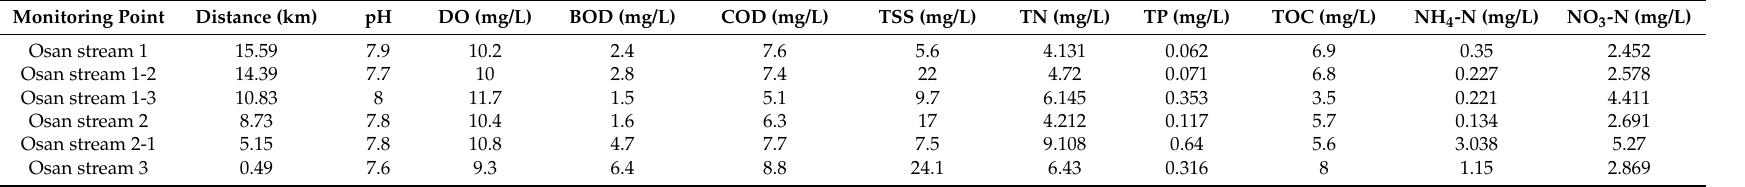
Table 1. Water quality average at the monitoring points of Osan stream drain from January 2015 to July 2016. Monitoring